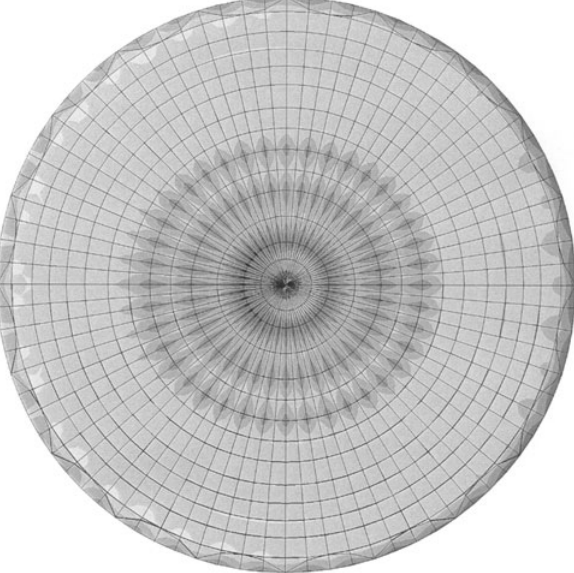
Figure 12 Von Mises stress concentration at shear sliding interface [3] .